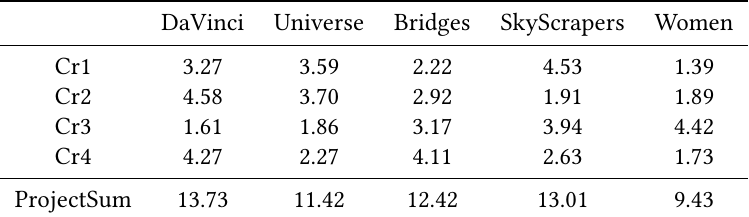
Table 6 Final table of expert evaluation.